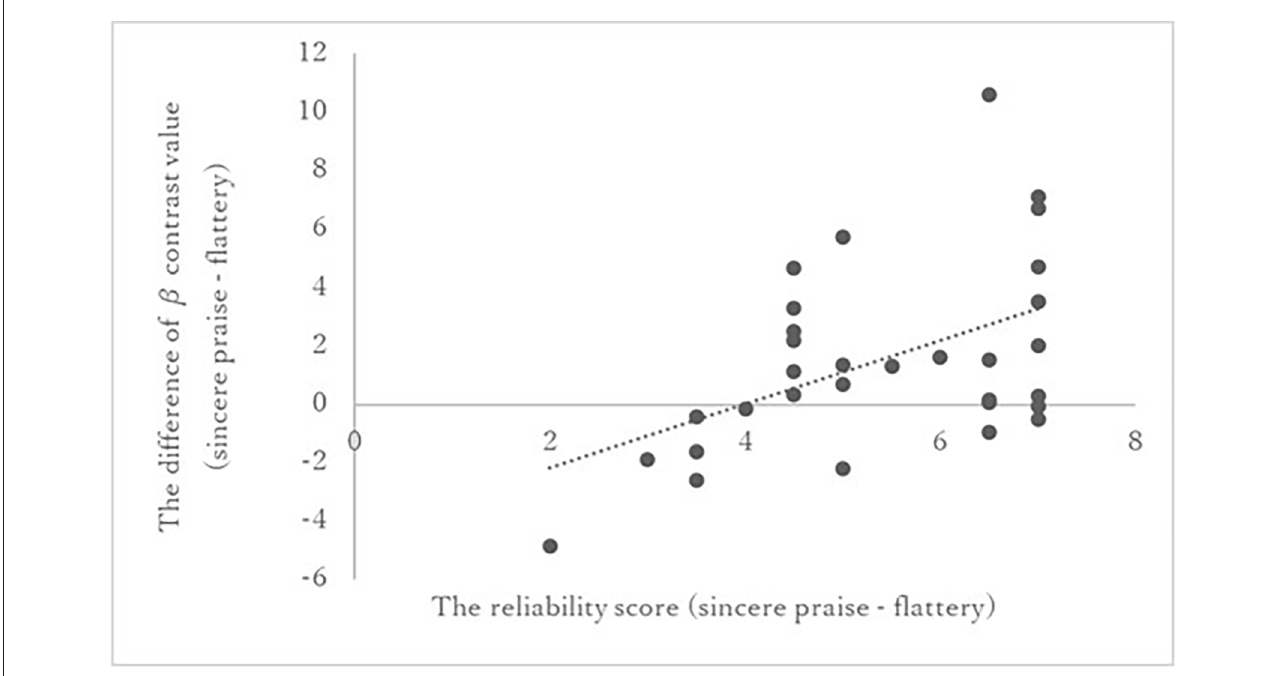
FIGURE4 Correlation between reliability score and PCC activation in the sincere praise and flattery conditions. Pearson’s correlation between the reliability score and activity in the PCC. Higher reliability scores correlated with greater activity in the PCC during sincere praise compared to flattery. PCC, posterior cingulate cortex.